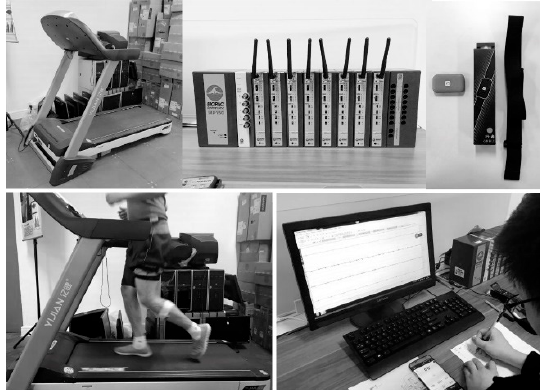
Figure 1. Experimental equipment and recording scene.